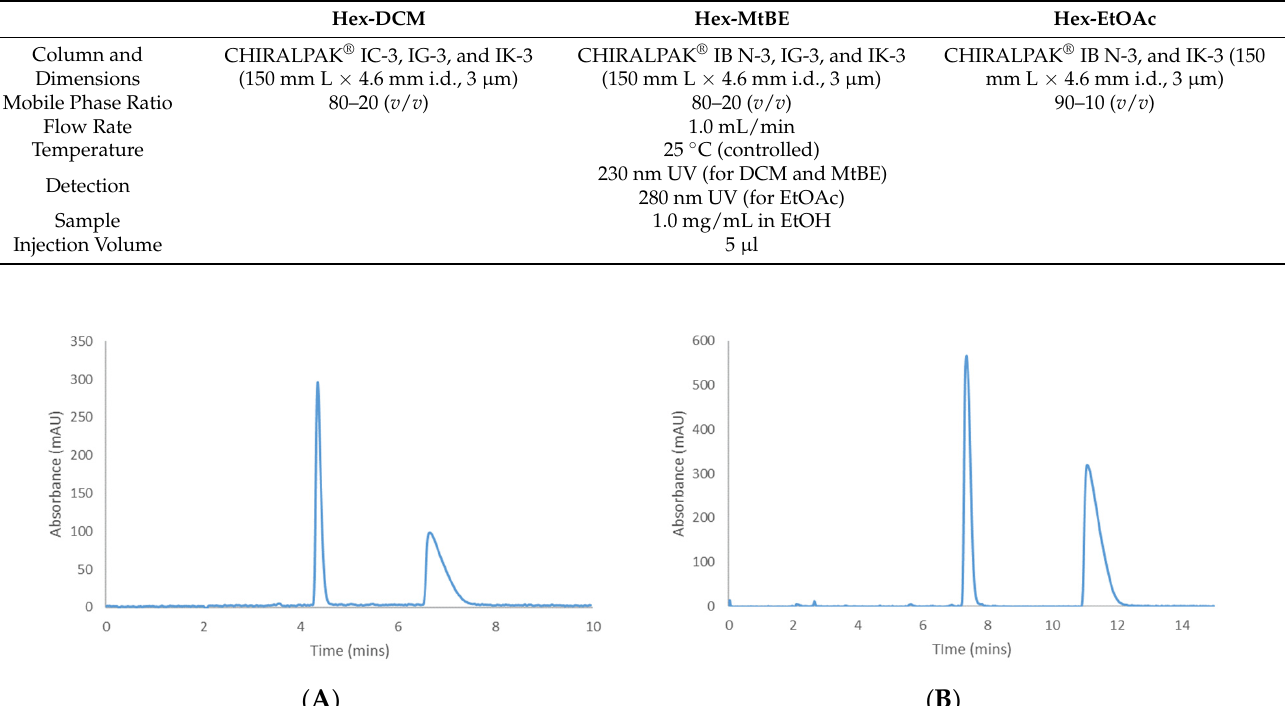
Table 1. Summary of analytical screening results yielding separations of CBC and CBL.